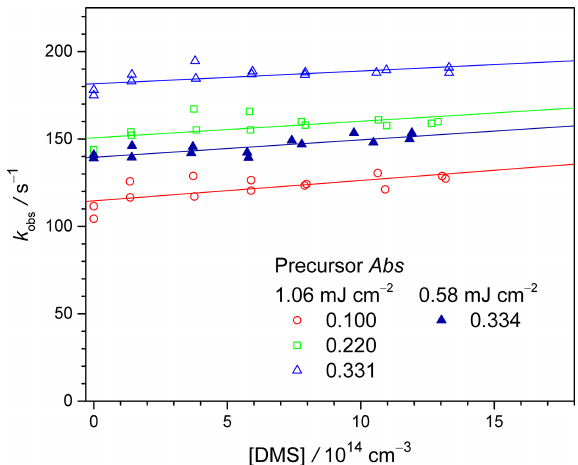
Figure 4. Plot of the observed decay rate coefficient of MVKO k obs against [DMS] at various laser fluences and precursor absorbances (Exp#15–18). For each data point, the fitting error bar is less than 1% (thus, not